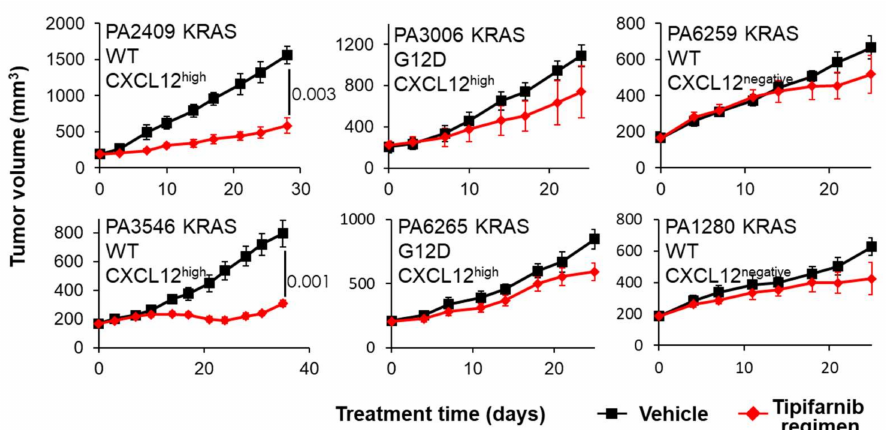
Figure 4. Tipifarnib inhibits tumor growth in WT KRAS CXCL12-producing PDAC PDX models. Mice bearing established subcutaneous PDX tumors were treated with oral tipifarnib BID for 25–35 days. CXCL12 + /KRAS WT tumors responded well (left panels), whereas CXCL12 + /KRAS-mutant and CXCL12 − /KRAS WT tumors were unaffected. PDAC, pancreatic ductal adenocarcinoma; PDX, patient-derived xenograft; WT, wild-type. Unpaired, two-tailed p values for PA2409 and PA3546 are depicted on the